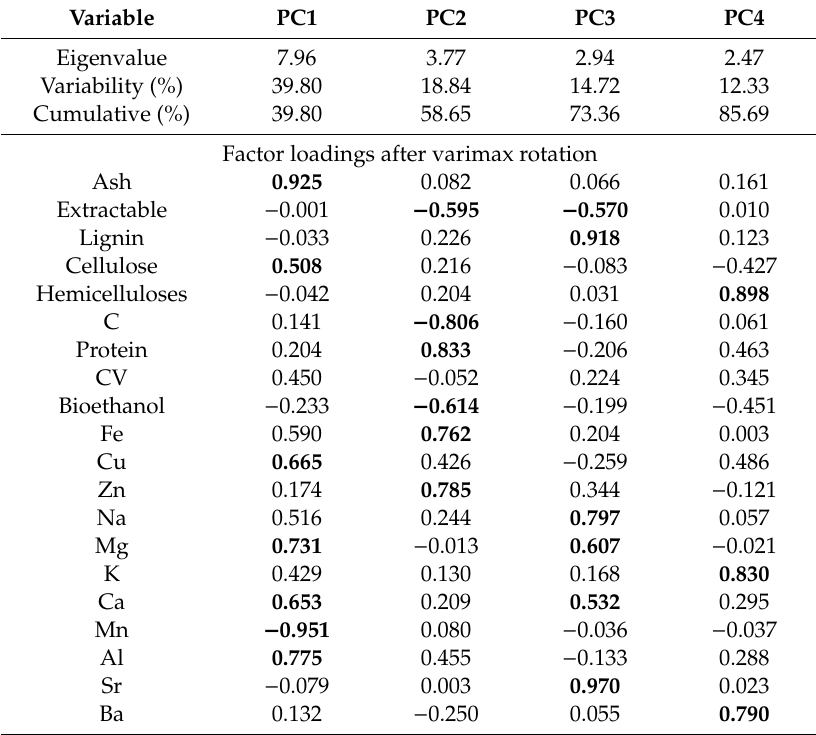
Table 6. Varimax rotated factor loadings of significant